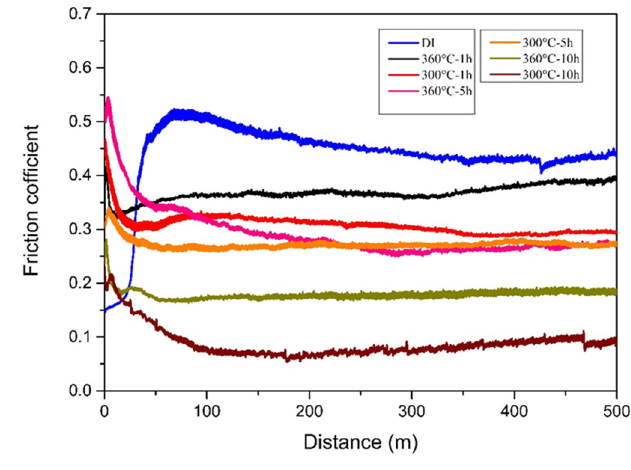
Figure 7. Comparison of friction coefficients among the specimens after dry wear testing.